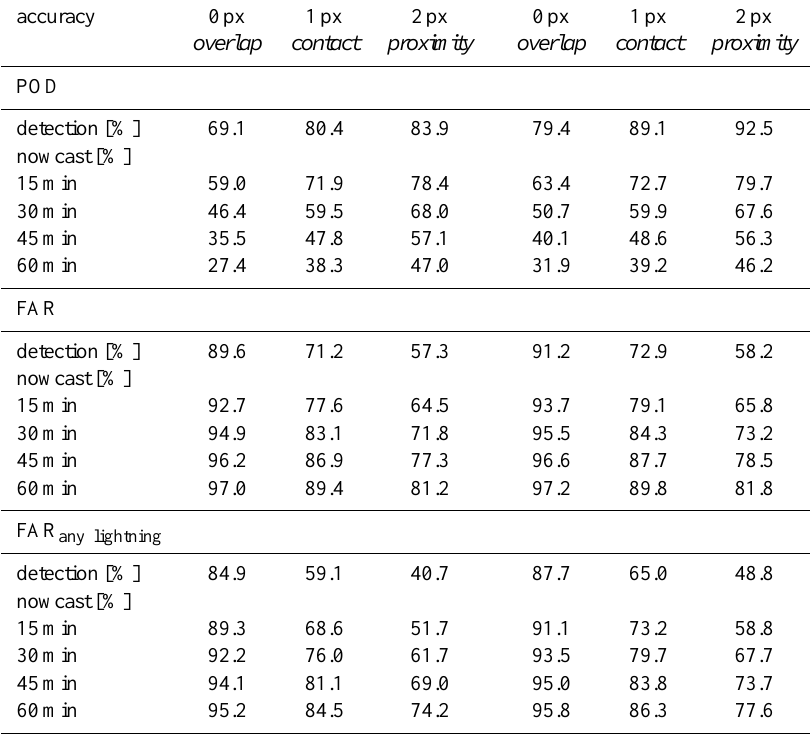
Table 2. Pixel-based validation scores for the current Cb-TRAM detection scheme for mature storms during daytime, and the 15, 30, 45 and 60min forecasts. Top – POD for intense lightning pixels ( > 10flashespixel − 1 15min − 1 ); centre – FAR with regard to intense lightning pixels ; bottom – FAR any lightning with regard to pixels containing any lightning ( > 0flashespixel − 1 15min − 1 ).